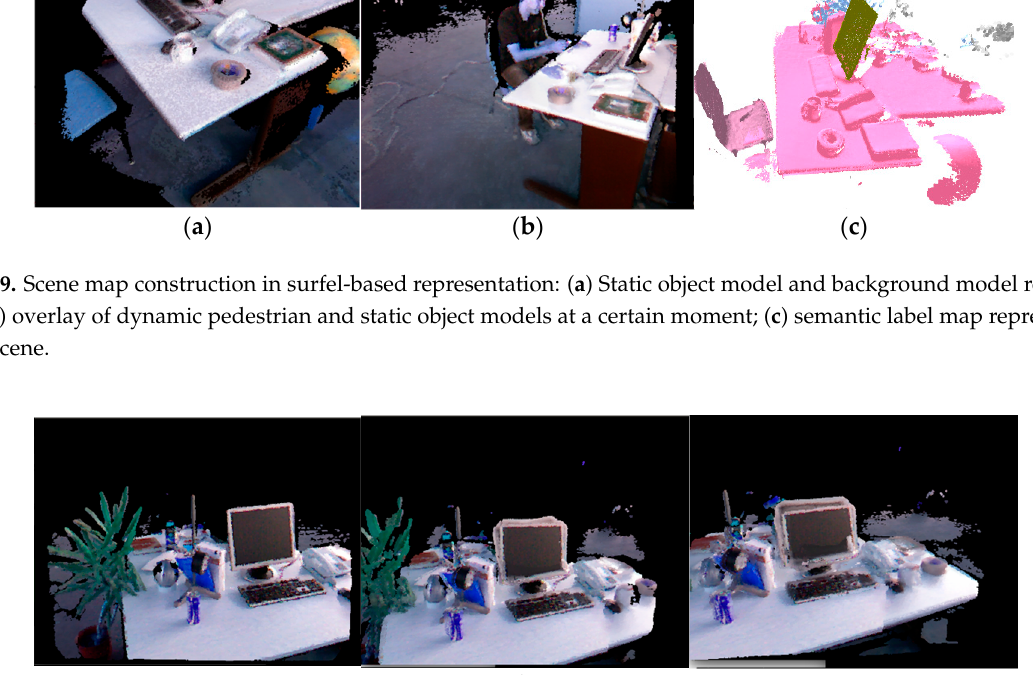
Figure 10. Object TV model fuse construction with different 3D tracking results displayed: ( a ) Accurate 3D tracking result and object model fuse construction; ( b , c ) 3D tracking results with errors and object model fuse construction with ghosts.